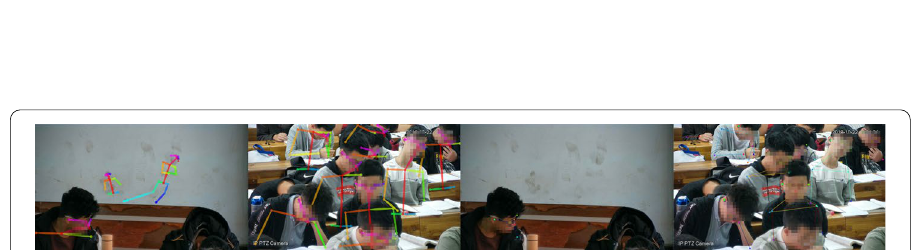
Fig. 5 Comparison of the pose estimation results. The pose estimation results of our method (right two images) and OpenPose method (left two images). OpenPose mistakenly identified wall patterns as human bodies, and the human pose estimation accuracy was poor. SE-HRNet yields significant improvements over OpenPose, reducing the human-body-object-detected error rate and increasing the accuracy of estimate key